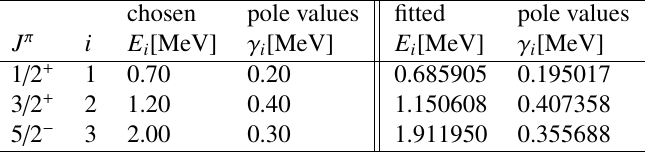
Table 1. Comparison of the originally chosen pole parameters of the R-matrix calculation (left) and the parameter values obtained by fit of the experimental data distorted by model defects.